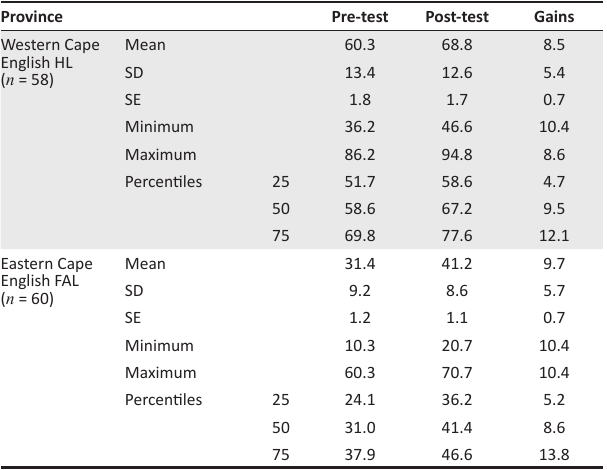
TABLE 5: Woodcock-Muñoz vocabulary test scores per province ( % ).